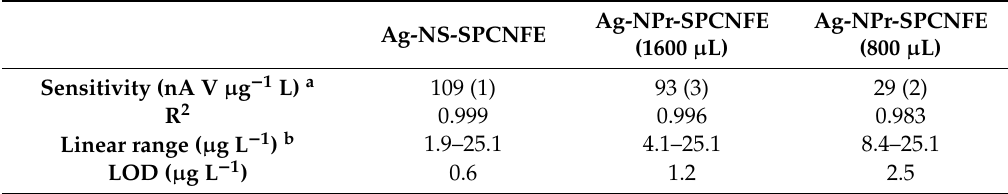
Table 1. Calibration data for the determination of As(V) in hydrochloric acid pH 2.0 applying an E d of − 1.3 V and a t d of 120